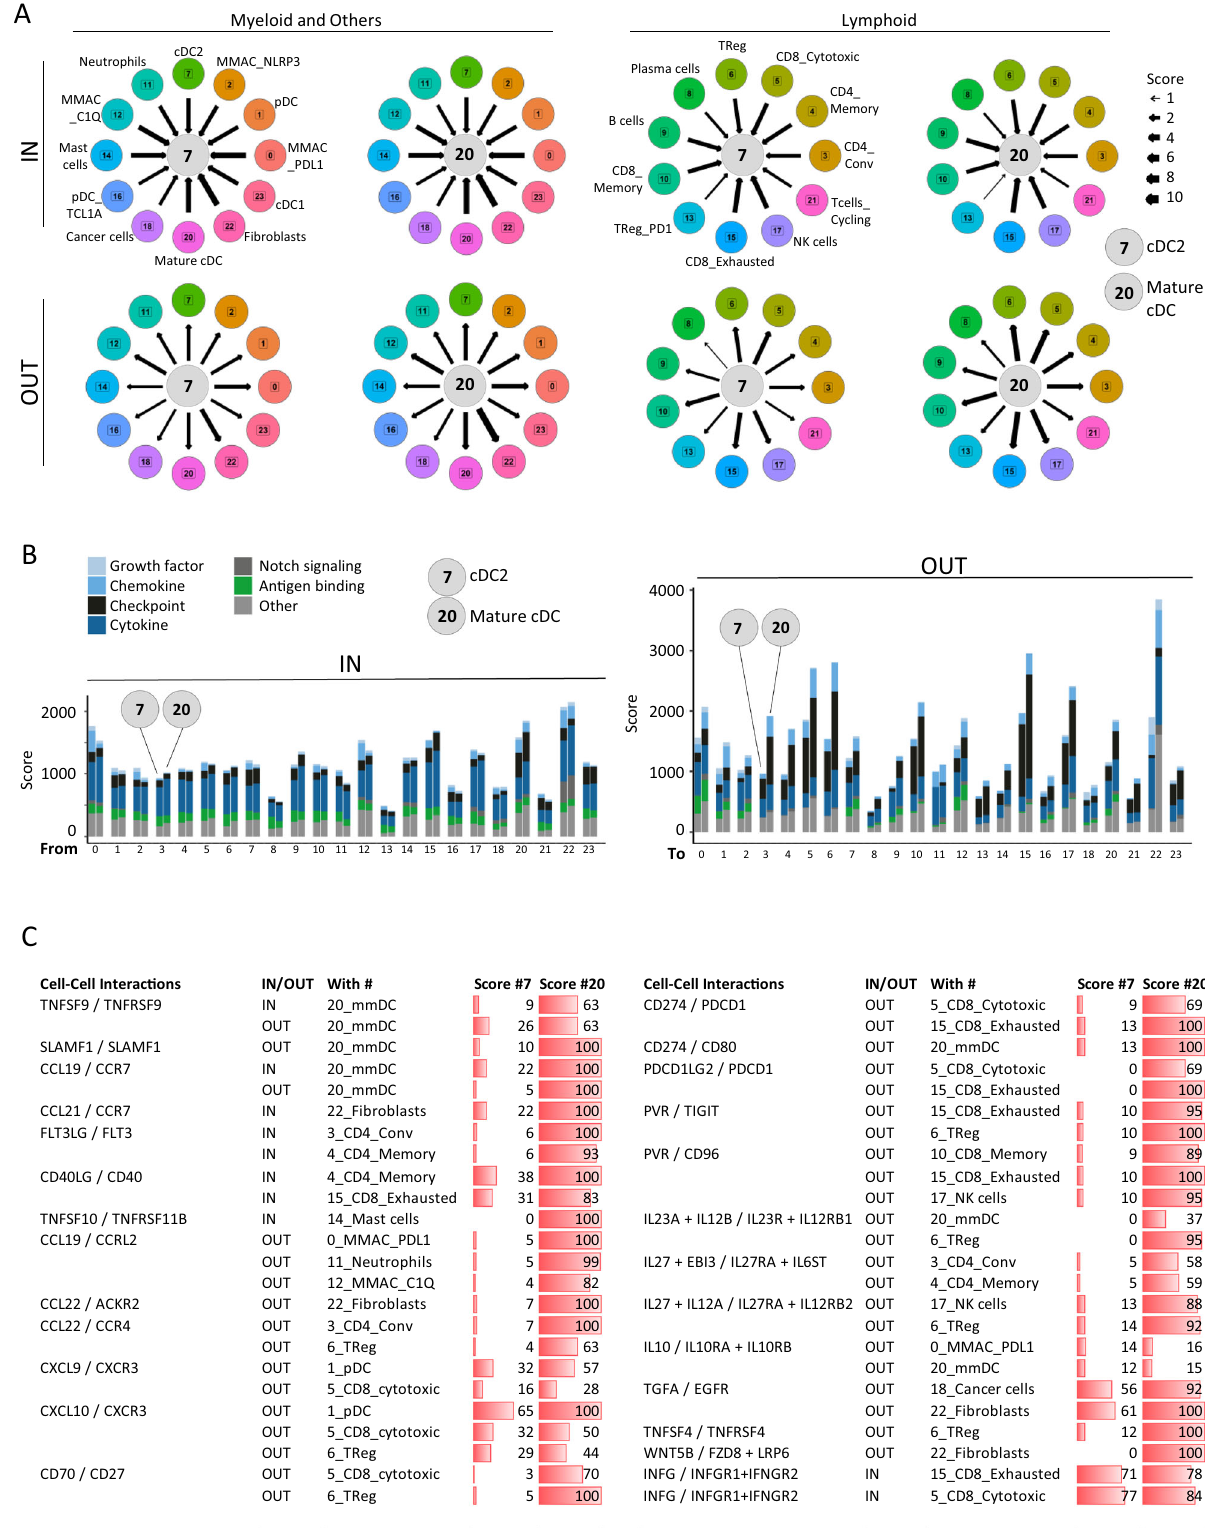
Fig. 7 HNSCC secretory cDC have an increased cell – cell communication network. Cell – cell communication analysis using ICELLNET 34 of cluster #7 and #20 as central cells in relation to other cell subsets of the tumor microenvironment. Cluster #19 of red blood cell was excluded from the analysis. A Networks. Interactions scores were normalized in a 0 – 10 scale represented by arrows. B Bar plots per interaction types. Bars are paired with the left bar being cluster #7 and the right cluster #20 that interact with the clusters numbered on the x -axis. Scores represent the sum of each individual interaction for each cluster – cluster interaction. C Table of selected interactions. Abbreviations: same as in Fig.